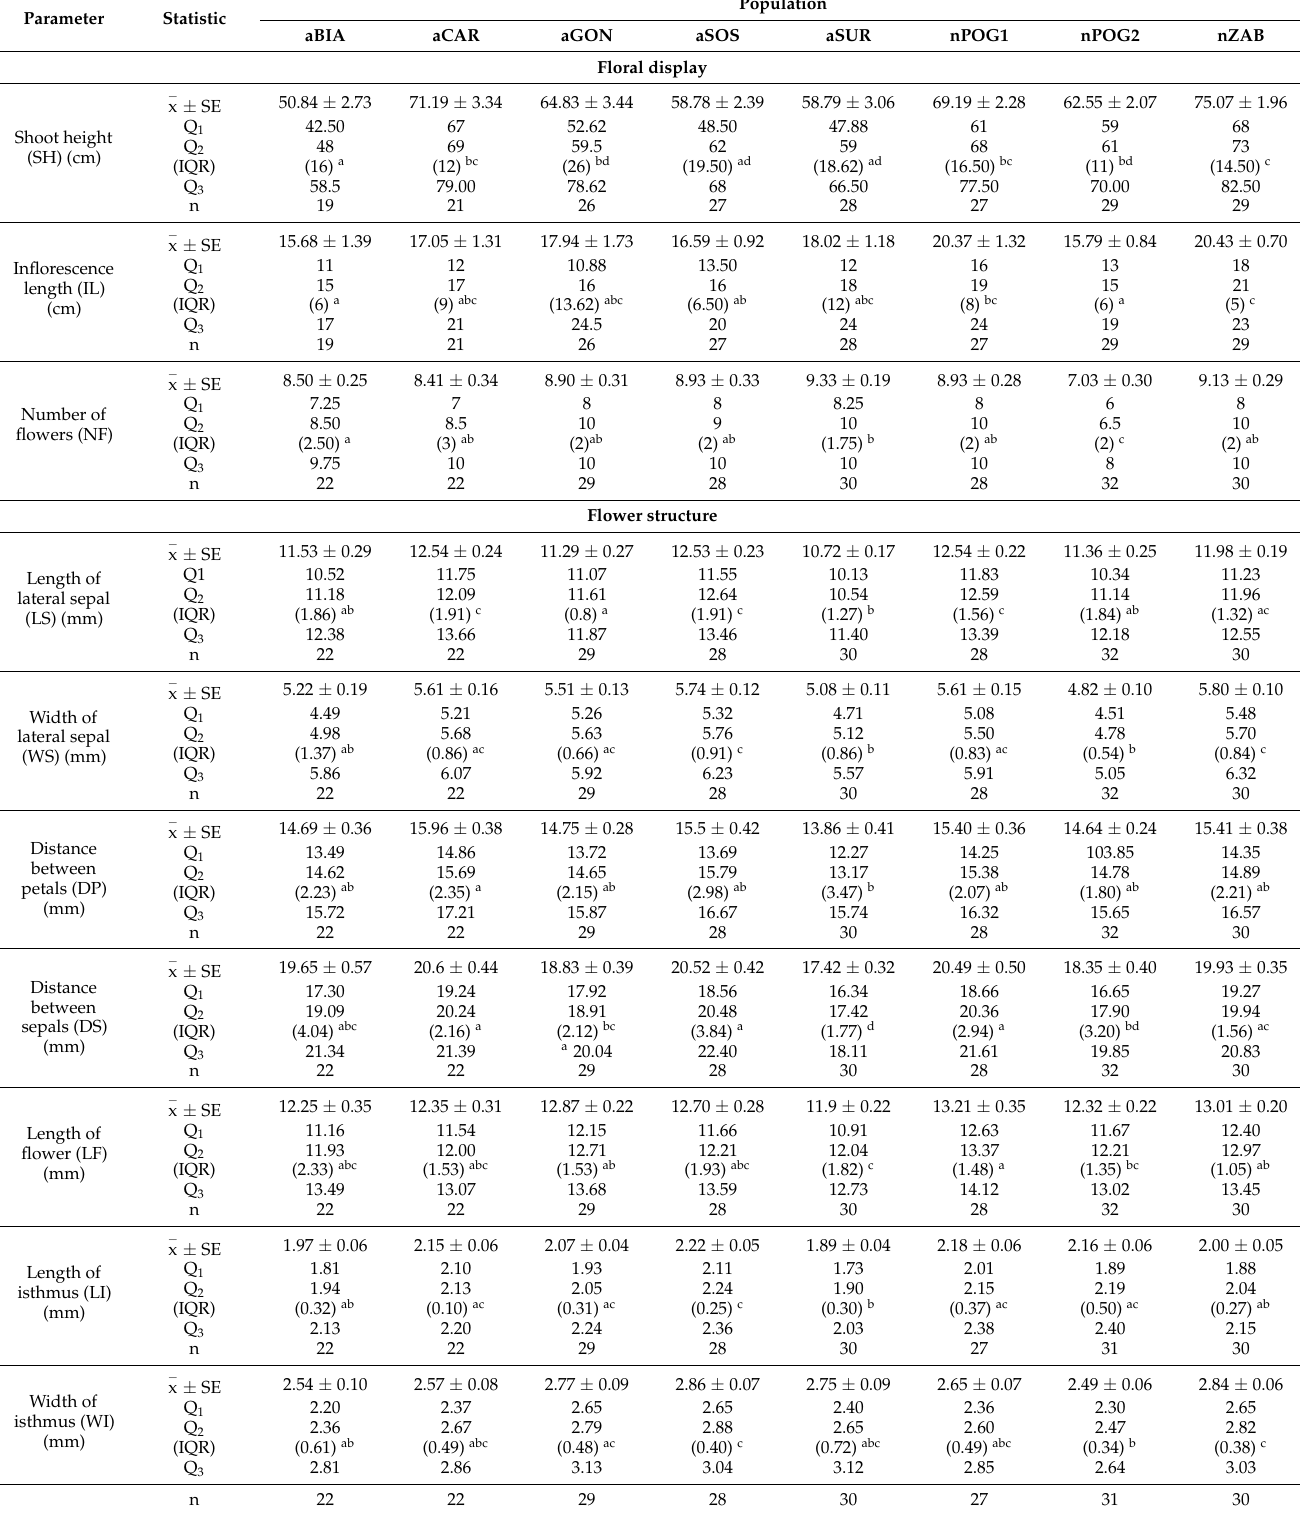
Table 1. Variation in floral display and flower structure in natural and anthropogenic populations of Epipactis helleborine . Data represent the mean (x) ± standard error (SE), lower quartile (Q 1 ), median (Q 2 ), upper quartile (Q 3 ), interquartile range (IQR), and biological replicate (n). Different letters indicate statistically significant differences according to the pairwise Wilcoxon rank sum test with the Benjamini–Hochberg adjustment ( p <